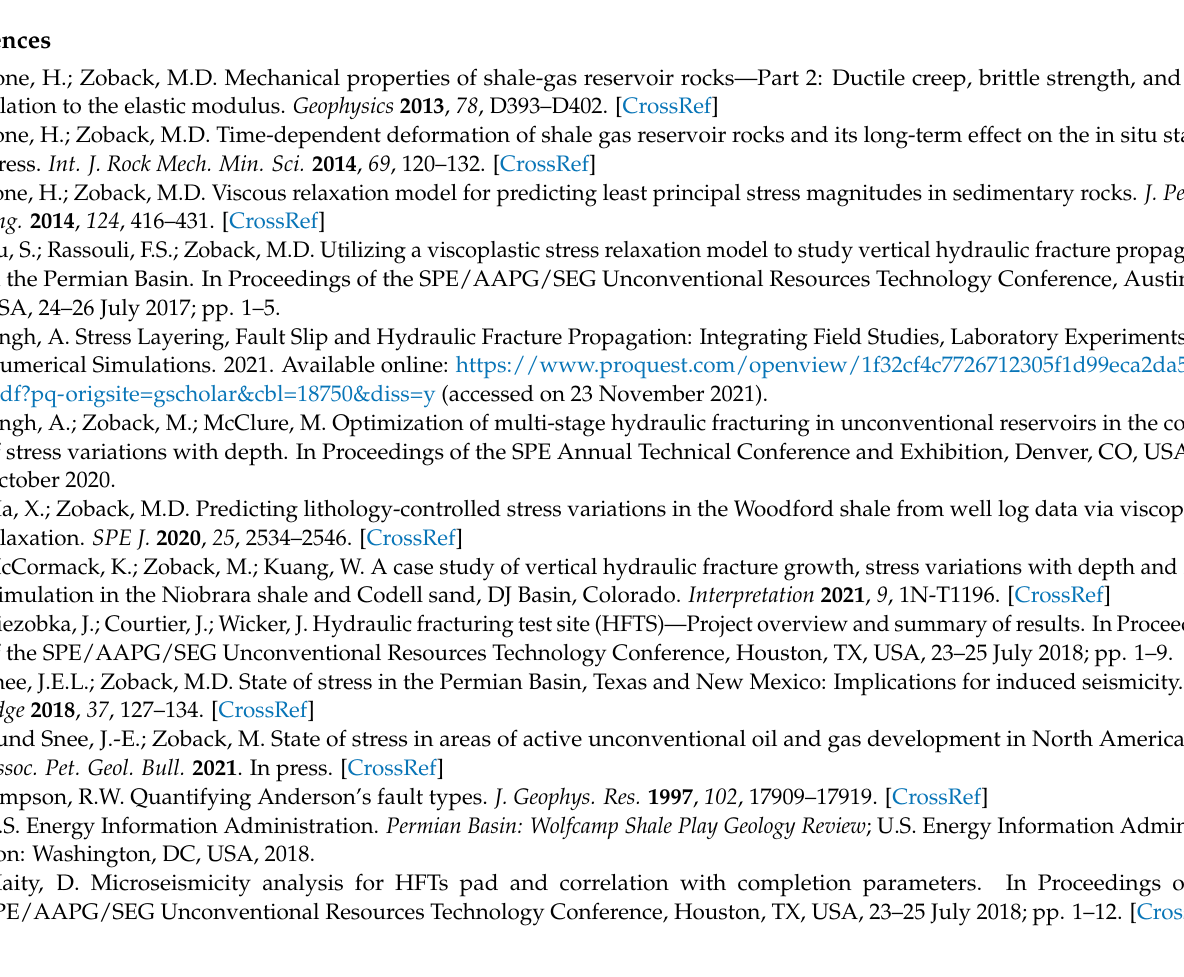
Figure A6. Stress polygon diagrams corresponding to DFIT measurements at ( a ) the toe of horizontal well 6SM at 7985 ft TVD ( b ) in vertical pilot well 7SU at 8070 ft